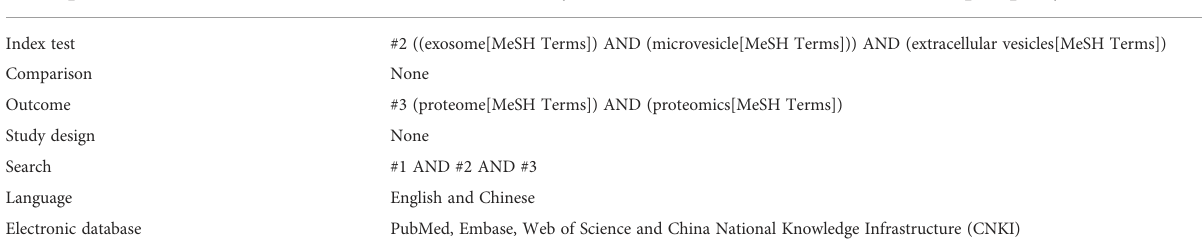
TABLE 1 The search strategy and Participant, Index test, Comparison, Outcome, and Study (PICOS).